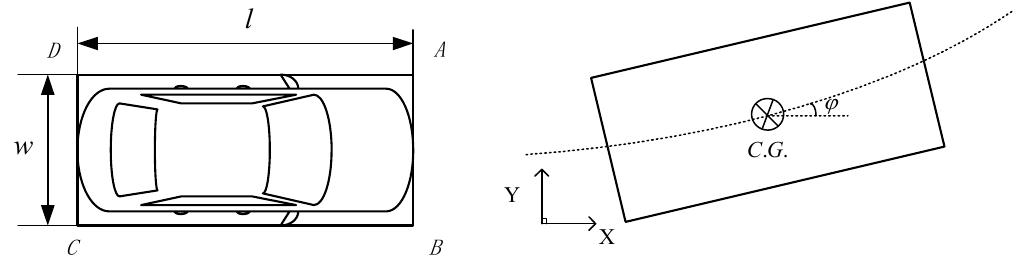
Figure 3. Rectangular vehicle model.